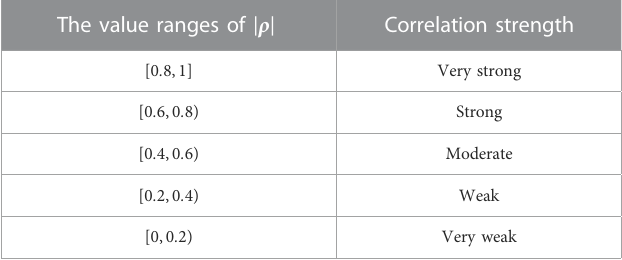
TABLE 5 Correlation strength classi fi cation. The value ranges of | ρ